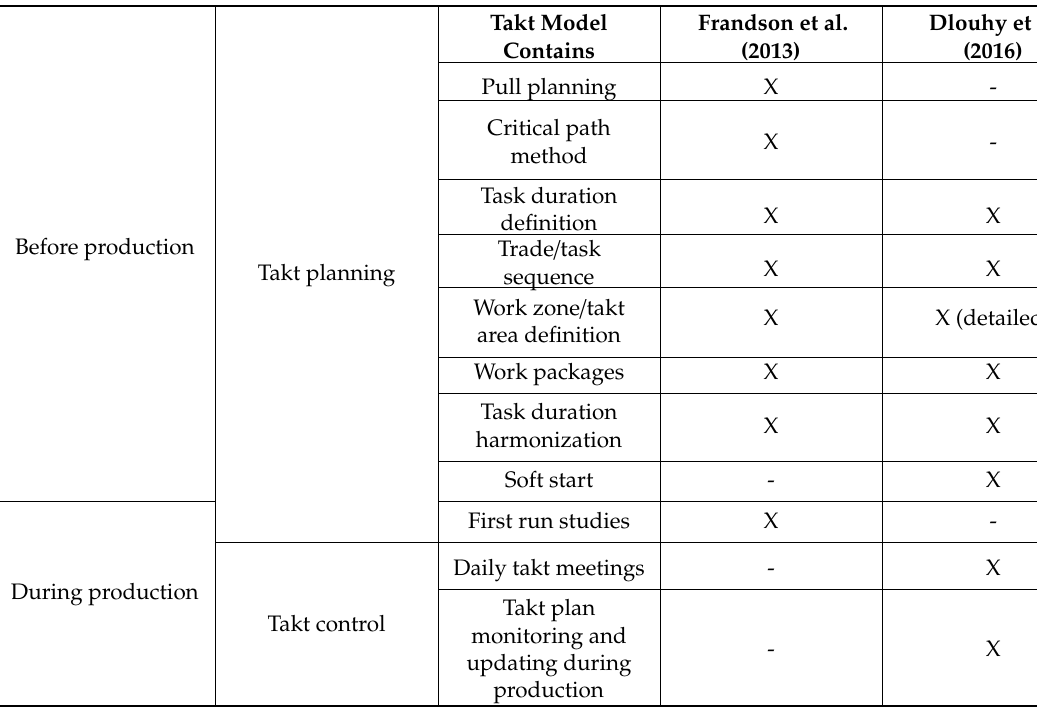
Table 1. Comparison of the Frandson et al. and Dlouhy et al. takt production